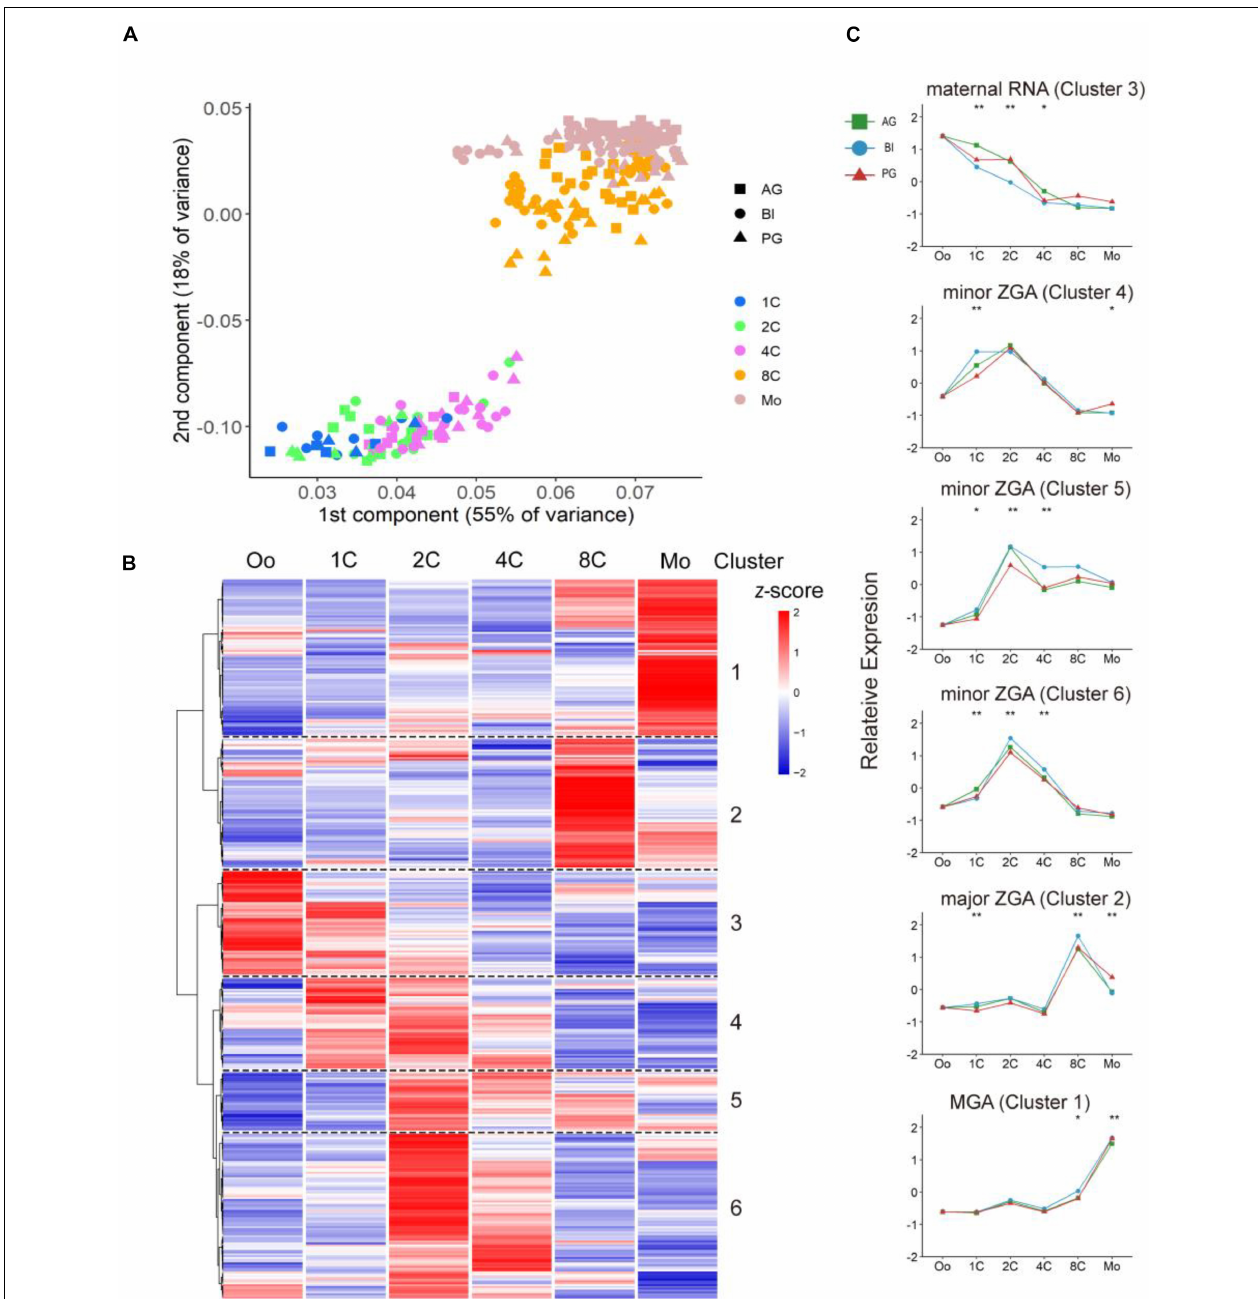
FIGURE 1 | Dynamic expression pattern of TFs in biparental and uniparental embryos. (A) Principal component analysis of expression TFs in biparental and uniparental cells. All cells were clustered into two distinct clusters. (B) Clustering of expression TFs in early BI cells from oocyte to morula (uniparental cells are similar to BI cells, figures are not shown). (C) TFs from BI cells were classified into five modules according to their expression patterns. Line plot shows relative expression in biparental and uniparental embryos in the corresponding pattern of BI cells. * p < 0.05, ** p < 0.01 (Kruskal–Wallis